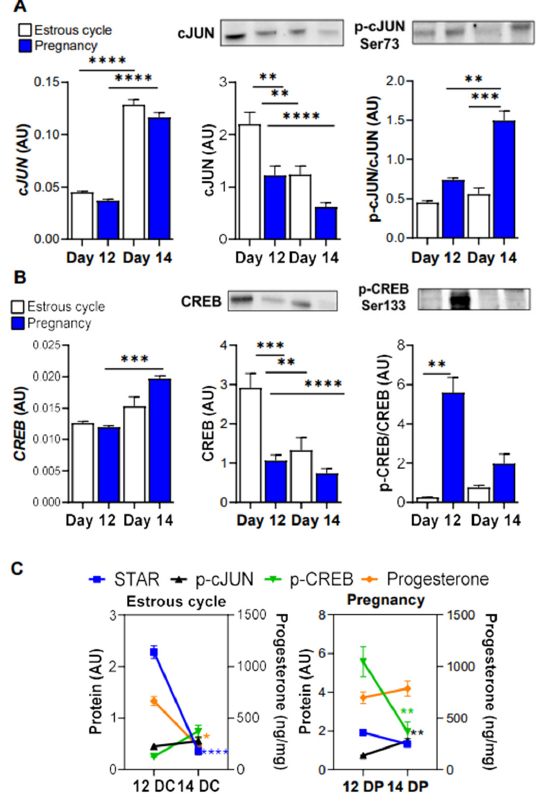
Figure 4. The expression of cJUN and CREB at mRNA and protein level in the porcine corpus luteum on day 12 and 14 of the estrous cycle and pregnancy. Gene expression was normalized to GAPDH (AU). Protein levels were normalized to total protein content (AU) using TGX Stain-Free gel technology ( A , B ). Representative blots are presented above the bar graphs. Changes in the content of STAR, p-cJUN and p-CREB (left y axis) and progesterone concentration (right y axis) in the porcine corpus luteum on day 12 and 14 of the estrous cycle (12DC; 14DC) or pregnancy (12DP; 14DP) ( C ). Comparison was made based on the data presented in subgraphs ( A , B ) and Figure 3D. Data are presented as mean ± SEM ( n = 5–7 per reproductive status). The analysis was performed by using a one- and two-way ANOVA with Tukey and Bonferroni post hoc test. Significant changes are indicated as * p < 0.05, ** p < 0.01, *** p < 0.001, **** p < 0.0001. AU, arbitrary